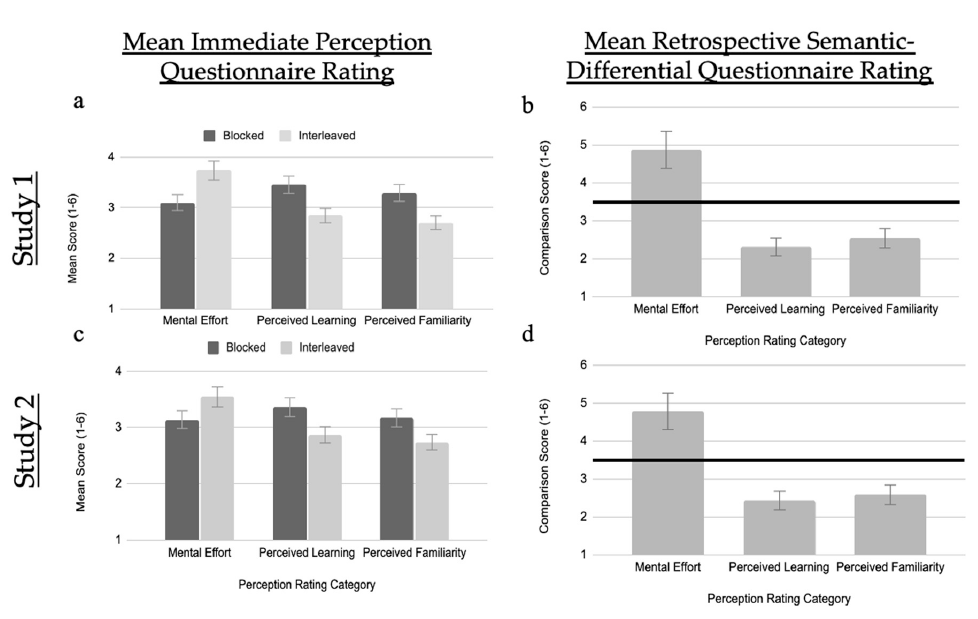
Figure 3. Mean immediate-perception questionnaire ratings for perceived mental effort, perceived learning, and perceived familiarity for the two study strategies for Study 1 ( a ) and Study 2 ( c ); Mean retrospective semantic-differential questionnaire ratings for retrospective perceived mental effort, retrospective perceived learning, and retrospective perceived familiarity when comparing study strategies for Study 1 ( b ) and Study 2 ( d ). 1 indicates a blocked study schedule, 6 indicates an interleaved study schedule. For the retrospective semantic-differential items, the solid black line at 3.5 indicates no preference for one strategy over another.